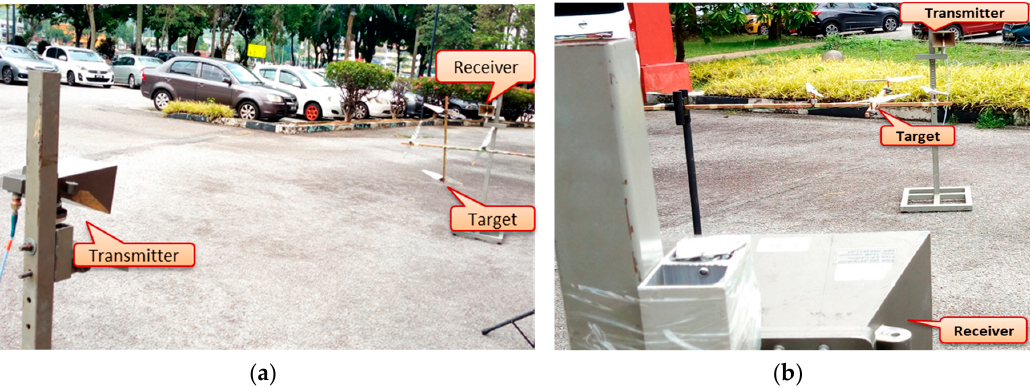
Figure 8. Outdoor experimental setup ( a ) Facing-Rx ( b ) Facing-Up. Rx: Receiver.